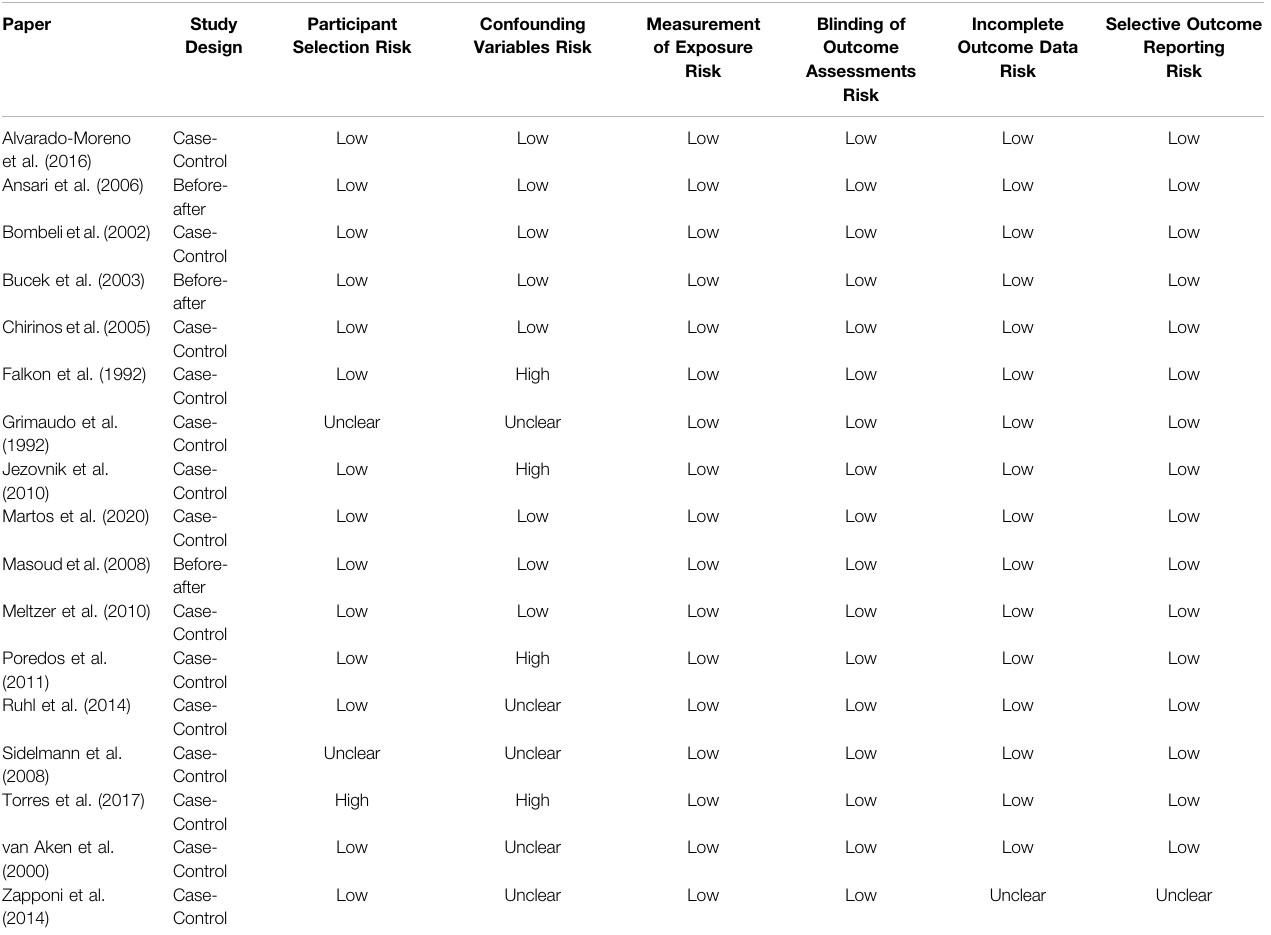
TABLE 1 | Risk of Bias